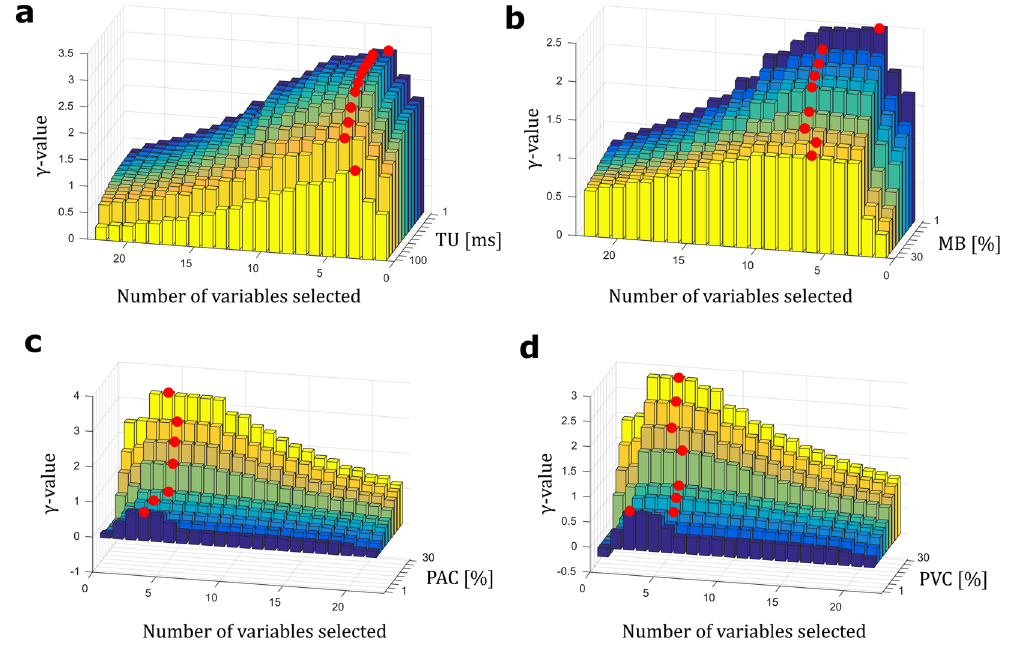
Figure 6. Robustness of the γ -metric to noisy data. ( a ) γ -value plotted as a function of the time uncertainty (TU, ms) applied to each R peak detection of the studied RR interval time series for each of the 1- to 22-variable models. ( b ) γ -value plotted as a function of the missing beats (MB, %) percentage applied to each RR interval time series for each of the 1- to 22-variable models. ( c ) γ -value plotted as a function of the premature atrial contraction (PAC, %) percentage applied to each RR interval time series for each of the 1- to 22-variable models. ( d ) γ -value plotted as a function of the premature ventricular contraction (PAC, %) percentage applied to each RR interval time series for each of the 1- to 22-variable models. In a, b, c, and d, increasing noise is indicated from dark blue (light noise) to bright yellow (strong noise). For each noise step, the red dot highlights the best n-variable model, i.e., the number of variables included in the model that has the highest γ -value. The analyses were performed on 7,400 1-min RR interval time series (NSR = 4,500, AF =